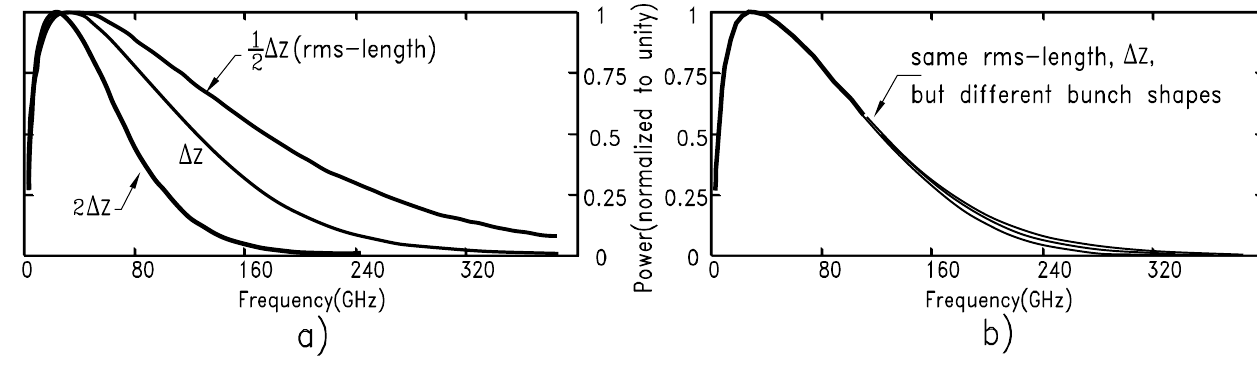
FIG. 3. Power spectrum that we predict to be emitted from a typical well-focused bunch obtained at ATF-BNL. (a) Radiation from a Gaussian charge distribution having different rms length (here (cid:14) z (cid:7) 1 : 8 psec , and for the sake of convenience, we measure the rms length in units of time, i.e., (cid:14) z (cid:7) 1 : 8 psec corresponds to c (cid:15) 1 : 8 psec (cid:1) 540 (cid:1) m ); (b) spectrum generated by three different bunch shapes: a Gaussian, an asymmetrical triangular (tail = head (cid:7) 4 = 1 ), and a rectangular charge distribution along the bunch-length